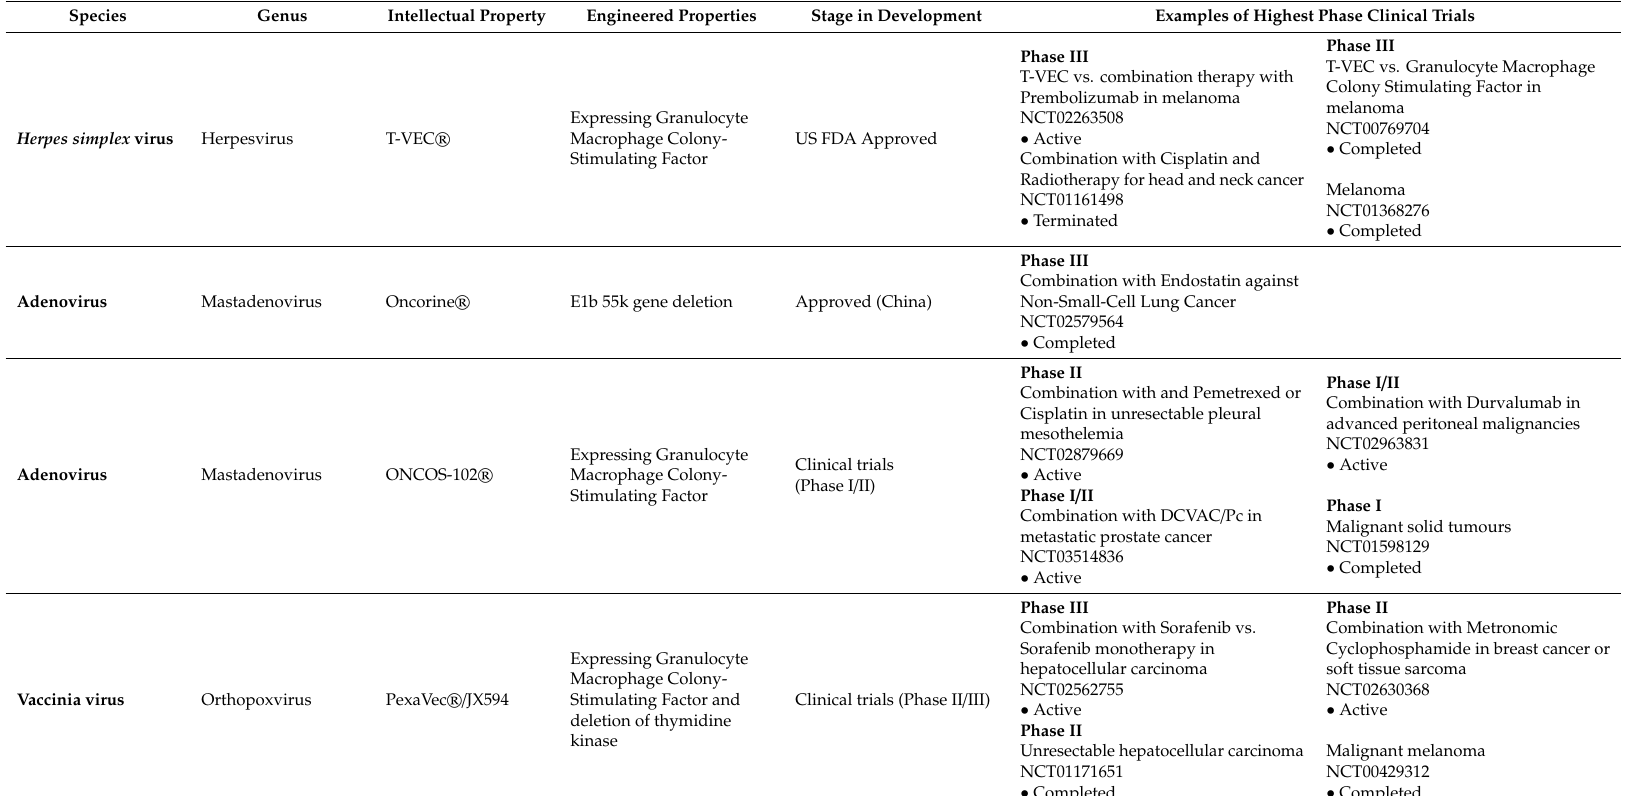
Table 1. Promising oncolytic